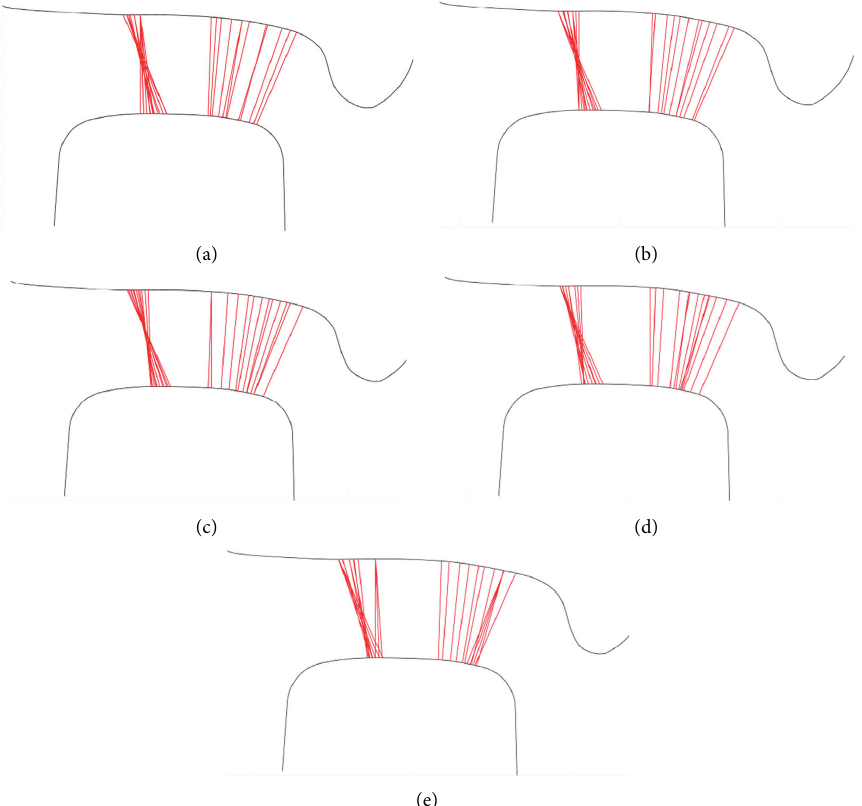
Figure 8: Distribution of wheel-rail contact points on the tread surface under different wheel wear. (a) 12.09 miriad milimetre (left). (b) 16.06 miriad milimetre (left). (c) 18.63 miriad milimetre (left). (d) 21.9 miriad milimetre (left). (e) 28.4 miriad milimetre